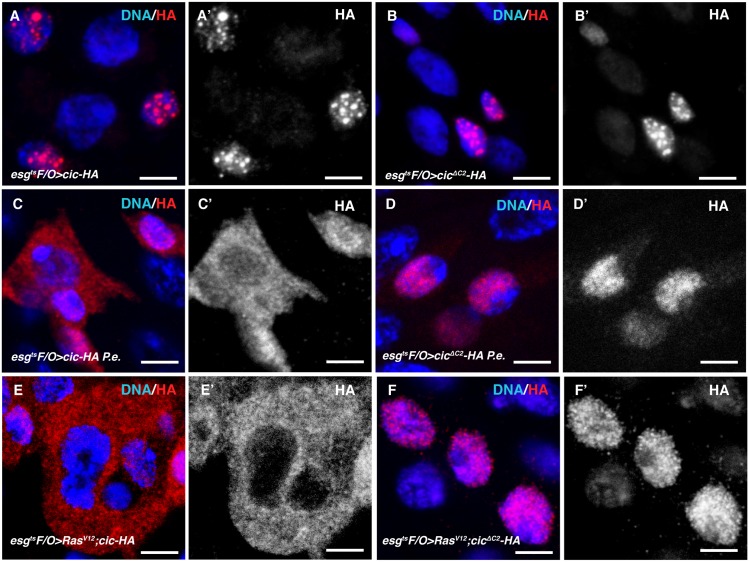
EGFR signaling controls Cic subcellular localization in ISCs.(A, B) Cic and CicΔC2 localized in the nuclei. Transgene expression was induced using the esg
ts
F/O system at 29°C for 2 days. HA-tagged Cic or CicΔC2 protein was detected by anti-HA antibody (red). Nuclear DNA is marked by DAPI staining (blue) (A) cic-HA overexpressing midgut. (B) cic
ΔC2
-HA overexpressing midgut. (C, D) Cic but not CicΔC2 protein accumulated in the cytoplasm after P.e. infection. (C) cic-HA overexpressing midgut, exposed to P.e. bacteria for 16 hours. (D) cic
ΔC2
-HA overexpressing midgut after 16 hours P.e. infection. (E, F) Cic protein accumulated in the cytoplasm when EGFR signaling was activated by Ras
V12S35. (E) Ras
V12S35 and cic-HA overexpressing midgut. (F) Ras
V12S35 and cic
ΔC2
-HA overexpressing midgut. Cic ΔC2 proteins stayed in the nucleus even after overexpressing Ras
V12S35 to activate MAPK signaling. Scale bars represent 5μm.